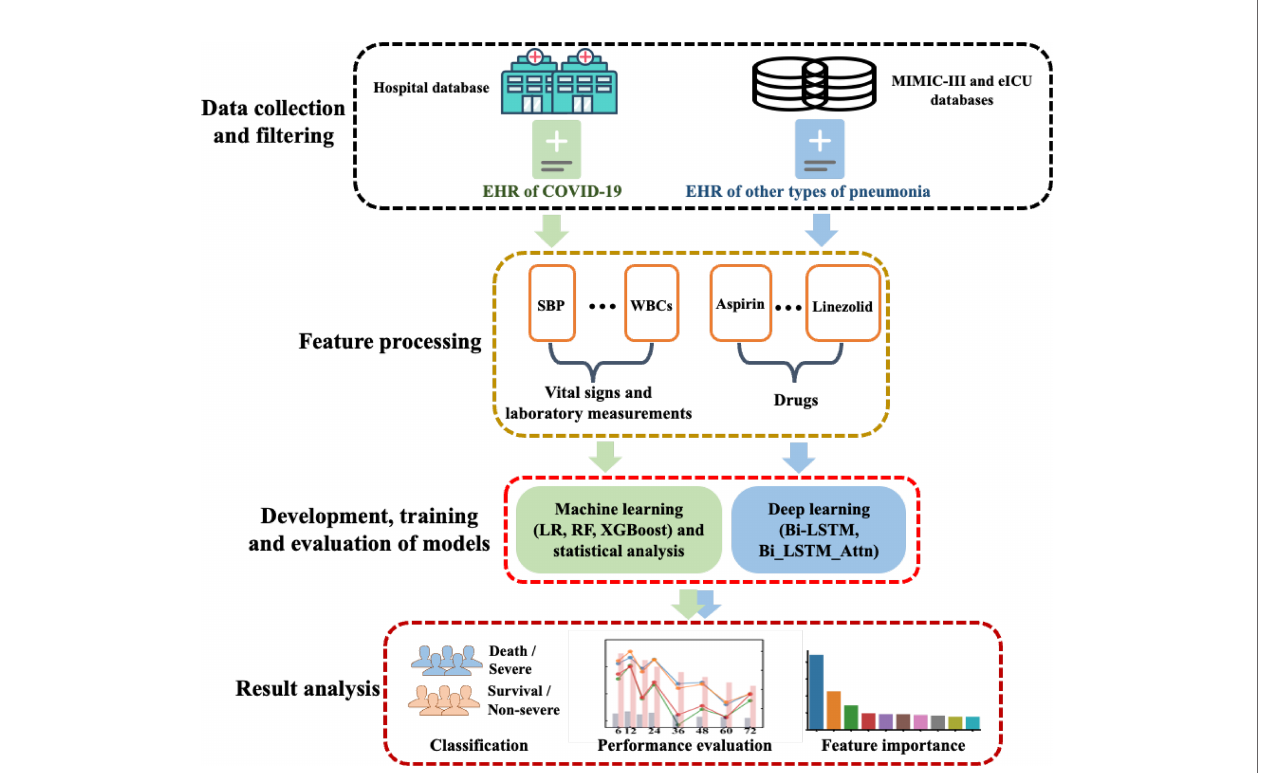
FIGURE 1 | The overall work fl ow of this study. EHR, electronic health record; LR, logistic regression; RF, random forest; SBP, systolic blood pressure; WBCs, white blood cell